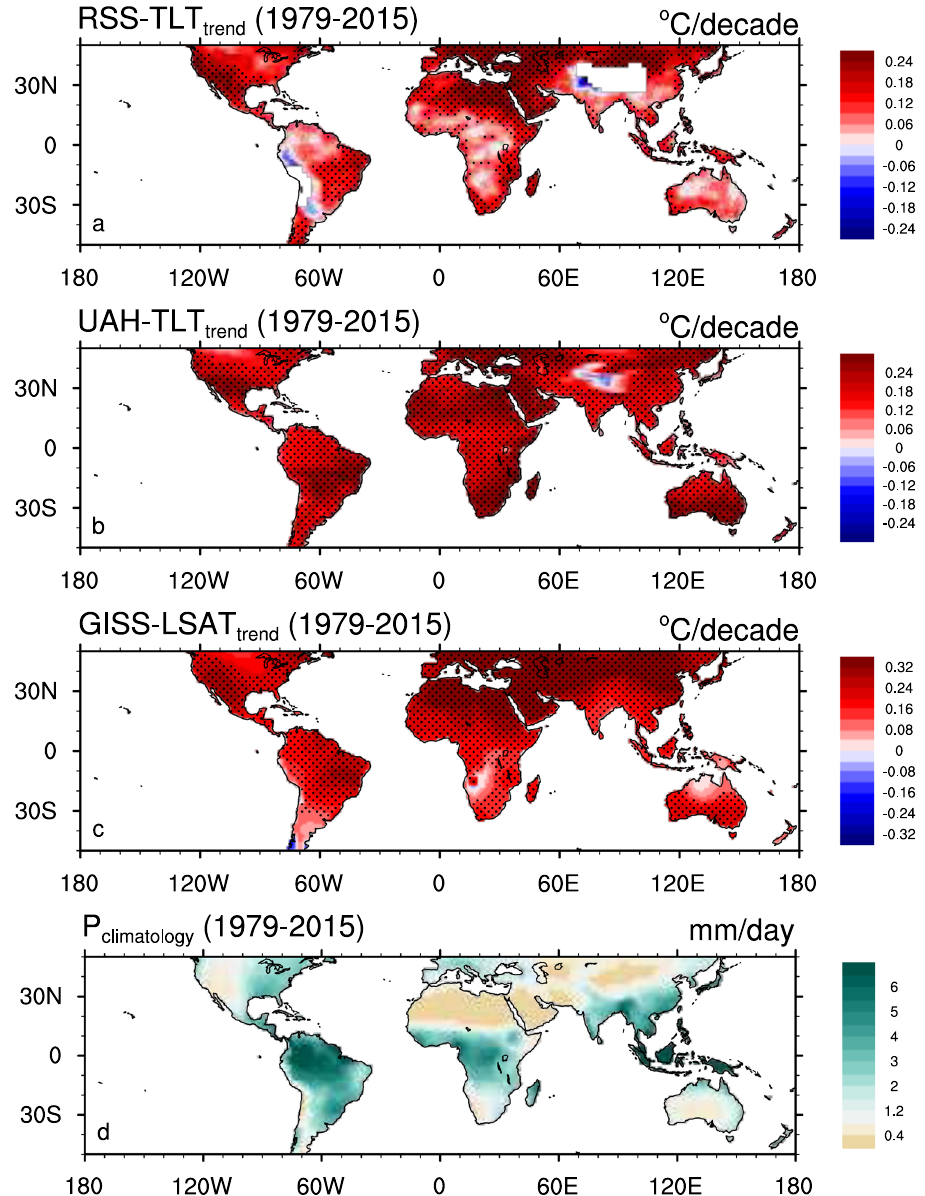
Figure 2. Spatial patterns of annual temperature trends (°C/decade) from ( a ) RSS-TLT, ( b ) UAH-TLT and ( c ) GISS-LSAT for the period 1979–2015 and ( d ) spatial patterns of climatological annual precipitation (mm/day) for the period 1979–2015, in 2.5° × 2.5° grid boxes over land. Stippling indicates regions where temperature trends are statistically significant (p < 0.1). Map was created using the NCAR Command Language (Version 6.0.0) [Software]. (2011). Boulder, Colorado: UCAR/NCAR/CISL/TDD. http://dx.doi.org/10.5065/